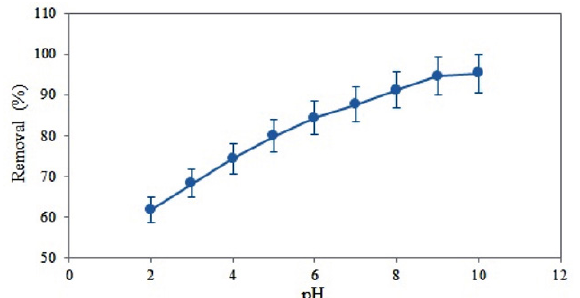
Figure 2. Effect of pH on MB adsorption by nanozeolite